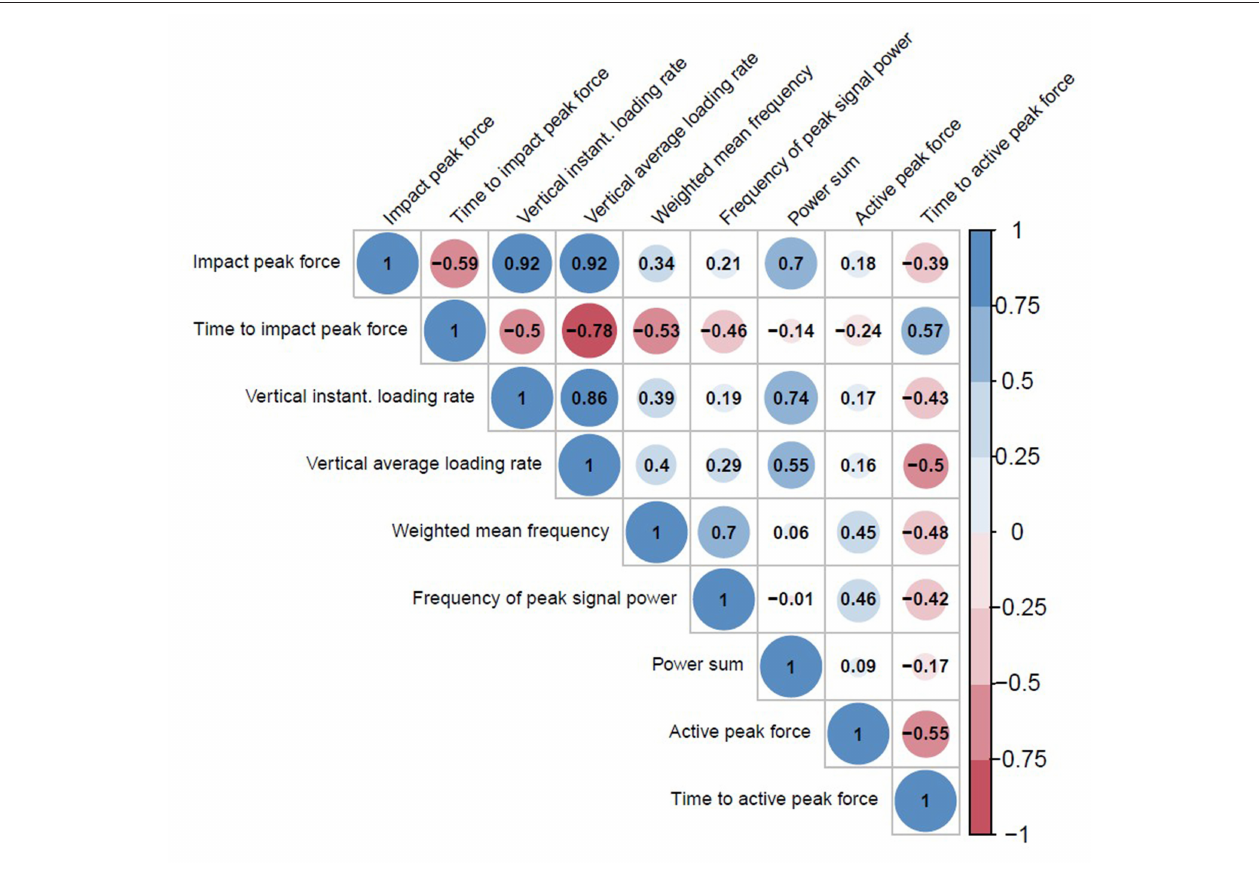
FIGURE 7 | Correlation matrix between the force characteristics. The size of the circle is proportional to the correlation. Blue colors and red colors indicate positive and negative correlations,